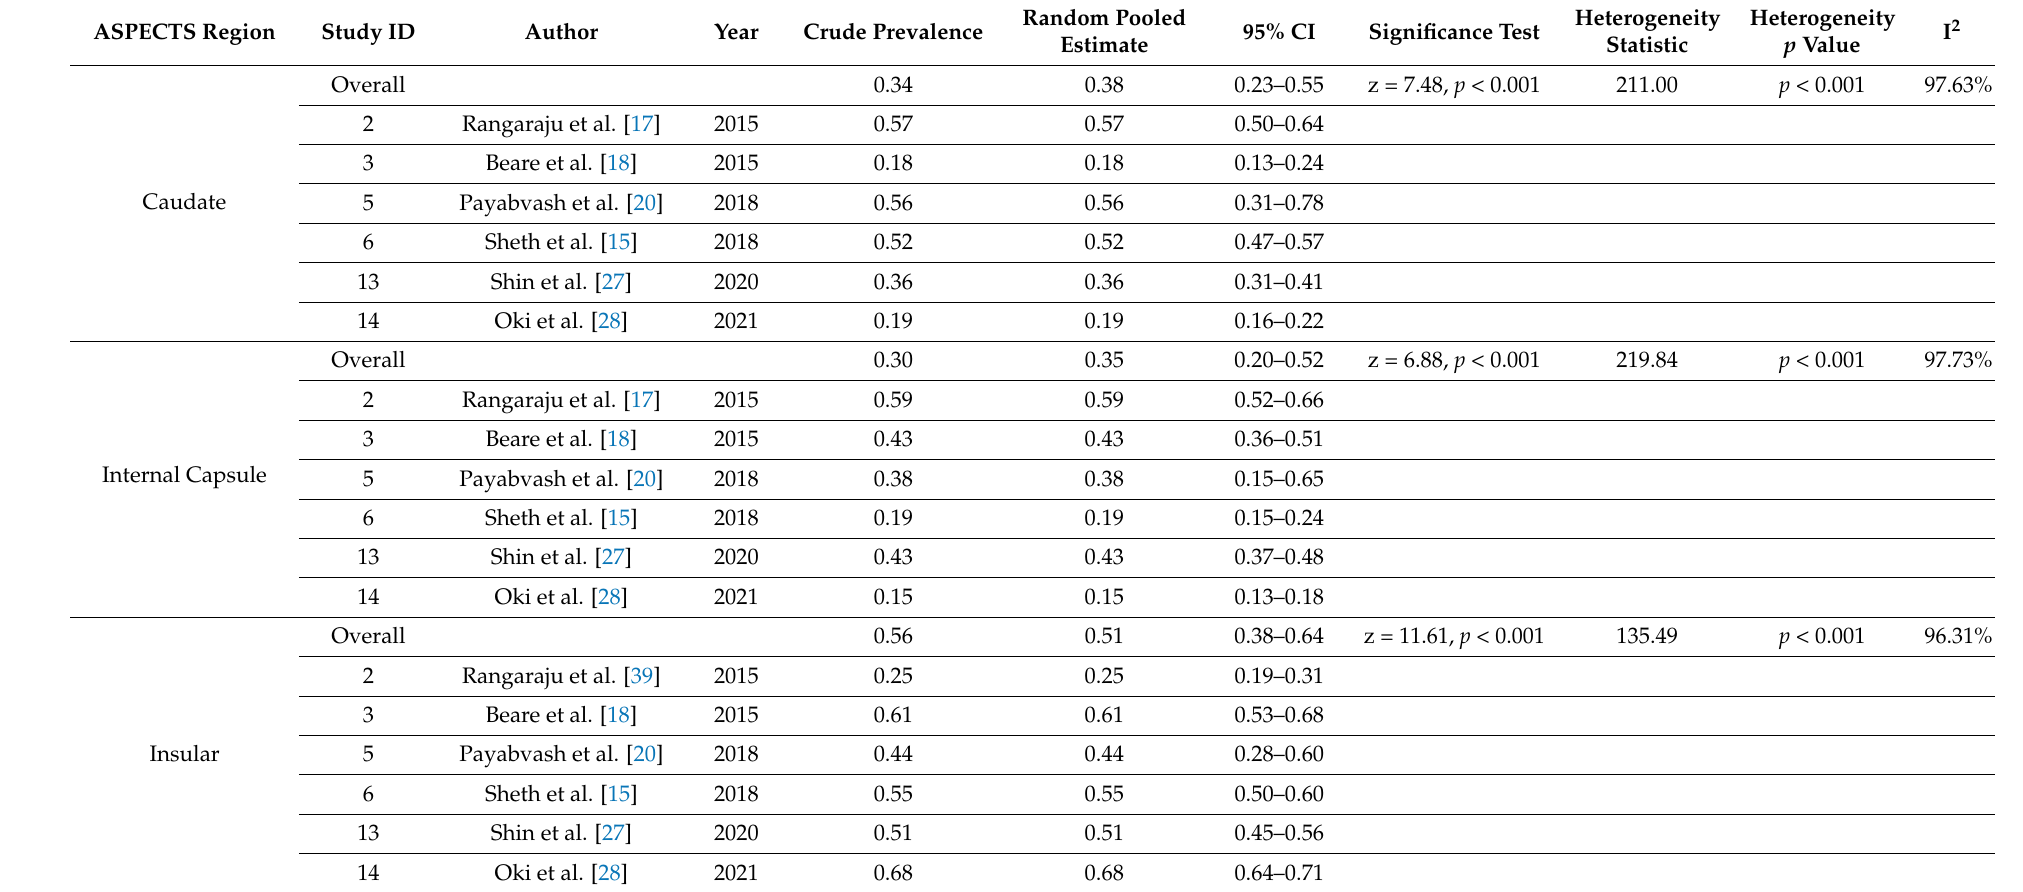
Table 3. Pooled estimate of prevalence of infarcts in ten ASPECTS